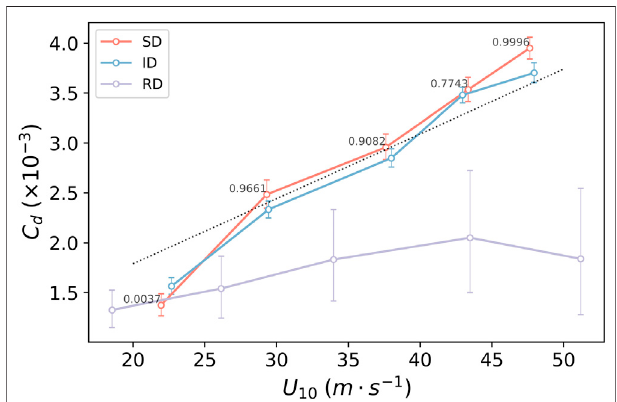
FIGURE 3 | Drag coef fi cient derived from the RD (purple), SD (red), and ID (blue) wind pro fi les for the MBW categories of 20 – 29 ms − 1 , 30 – 39 ms − 1 , 40 – 49 ms − 1 , 50 – 59 ms − 1 , and 60 – 69 ms − 1 . The error bar denotes the 95% con fi denceinterval.Thedot – dashlineisanextrapolationbasedonLarge and Pond (1981), which is applicable up to 25 ms − 1